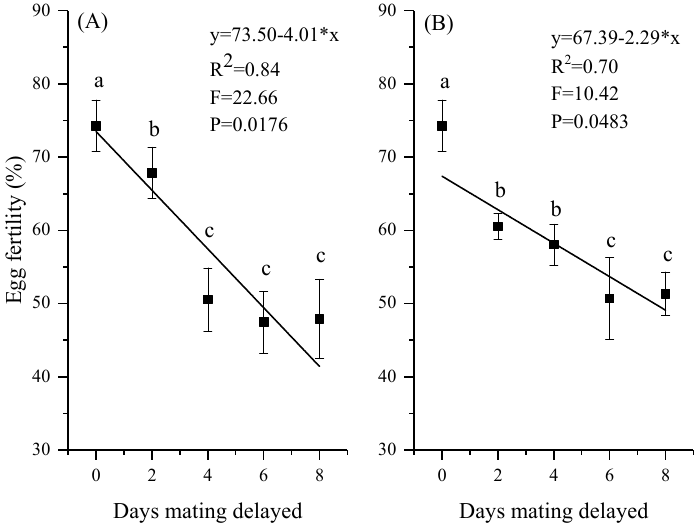
Figure 3. Mean ( ± SE) egg fertility of Henosepilachna vigintioctopunctata after female-delayed ( A ) and Figure 3. Mean (±SE) egg fertility of Henosepilachna vigintioctopunctata after female ‐ delayed ( A ) and male ‐ delayed ( B ) mating for 0–8 d. Values (±SE) with the same letter are not significantly different male-delayed ( B ) mating for 0–8 d. Values ( ± SE) with the same letter are not significantly different ( p > 0.05). ( p >